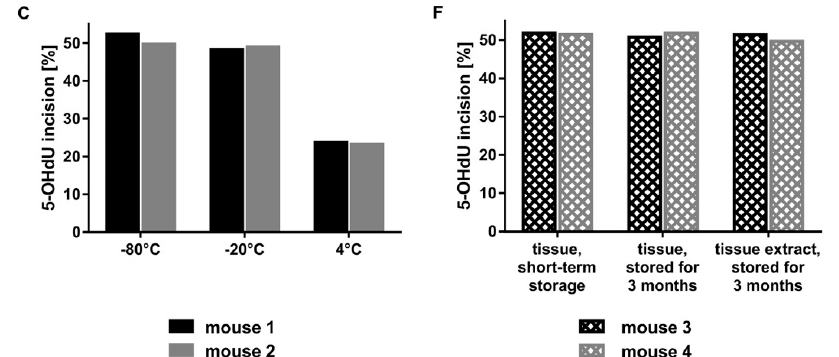
Figure 2. Storage stability. For assessment of short-term storage stability of murine liver extracts, incision activity was determined towards ( A ) the 8-oxodG, ( B ) the AP site analogue, and ( C ) the 5-OHdU containing oligonucleotide after 5-day storage of liver tissue extracts at − 80, − 20, or 4 ◦ C. Tissue extract protein amounts of two di ff erent mice were applied as follows: 6 µ g for the 8-oxodG, 1 µ g for the AP site analogue and 5-OHdU containing oligonucleotide. Regarding long-term storage stability, incision activity was determined towards the ( D ) 8-oxodG, ( E ) AP site analogue, and ( F ) 5-OHdU containing oligonucleotide after short-term (max. 5 days) or long-term storage (3 months) of liver tissue or after long-term storage (3 months) of tissue extracts. Tissue extract protein amounts of two di ff erent mice were applied as follows: 8 µ g for 8-oxodG, 1 µ g for the AP site analogue and 5-OHdU.